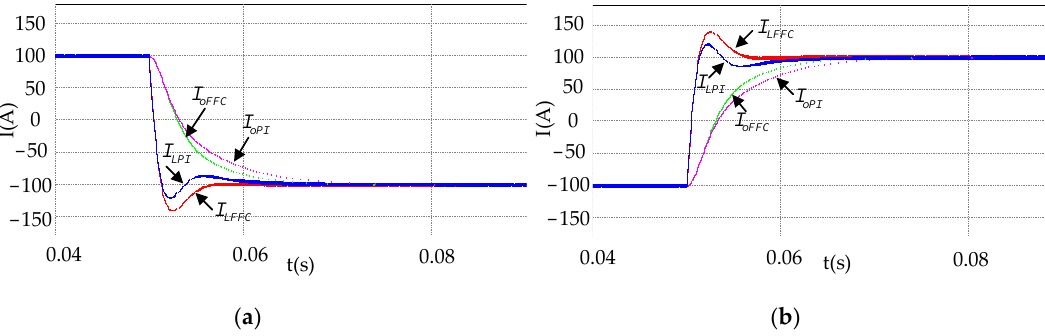
Figure 13. Waveforms of power flow reverse. ( a ) +100 A to −100 A conversion with PI and duty ratio feedforward control methods. ( b ) − 100 A to +100 A conversion with PI and duty ratio feedforward control methods.